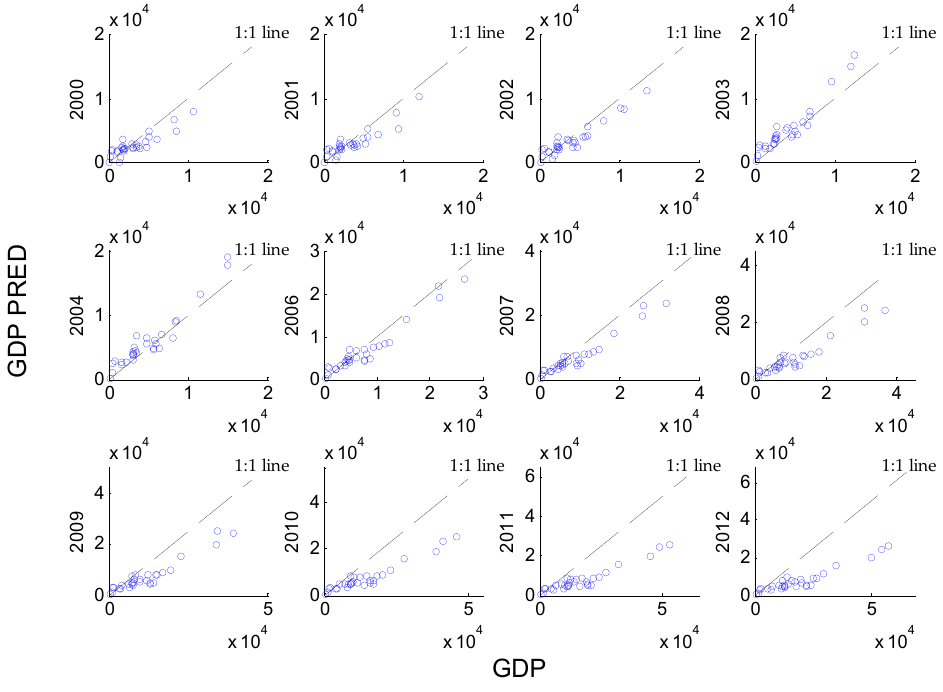
Figure 6. GDP and GDP PRED based on the estimation model of 2005.